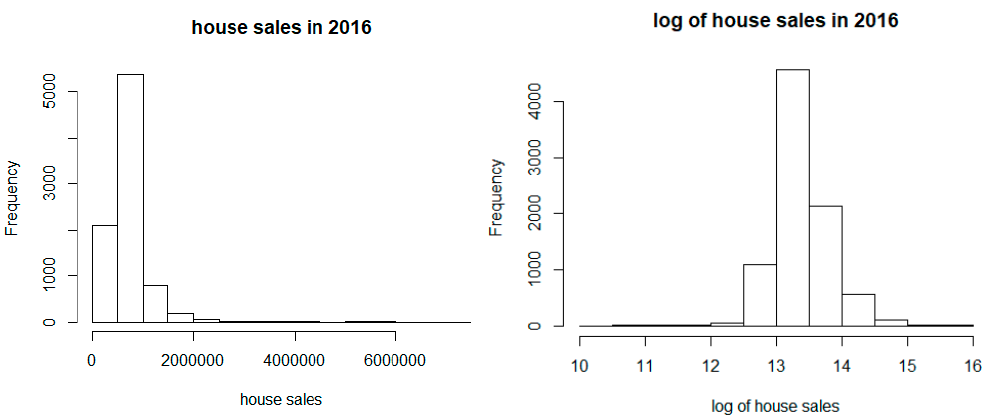
Figure 2. Distributions of house prices in 2016. ( a ) Histogram of house prices, ( b ) histogram of logarithmic house prices.